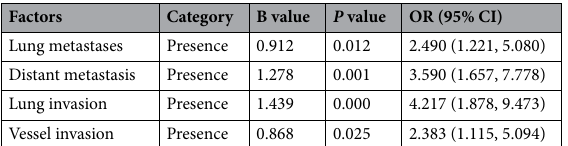
Table 4. Independent predictors by Cox regression analysis for thymic carcinoma.